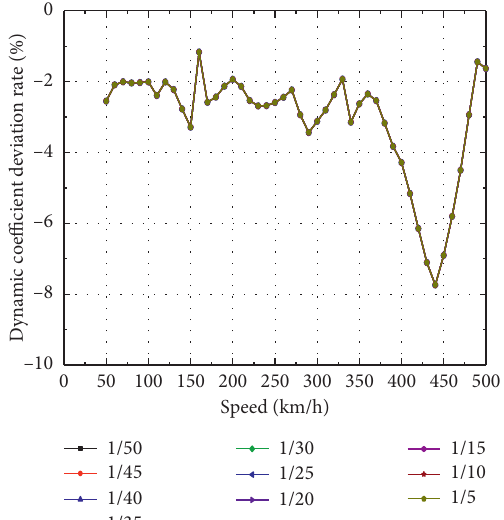
Figure 17: The maximum displacement of the bridge span of the VBI